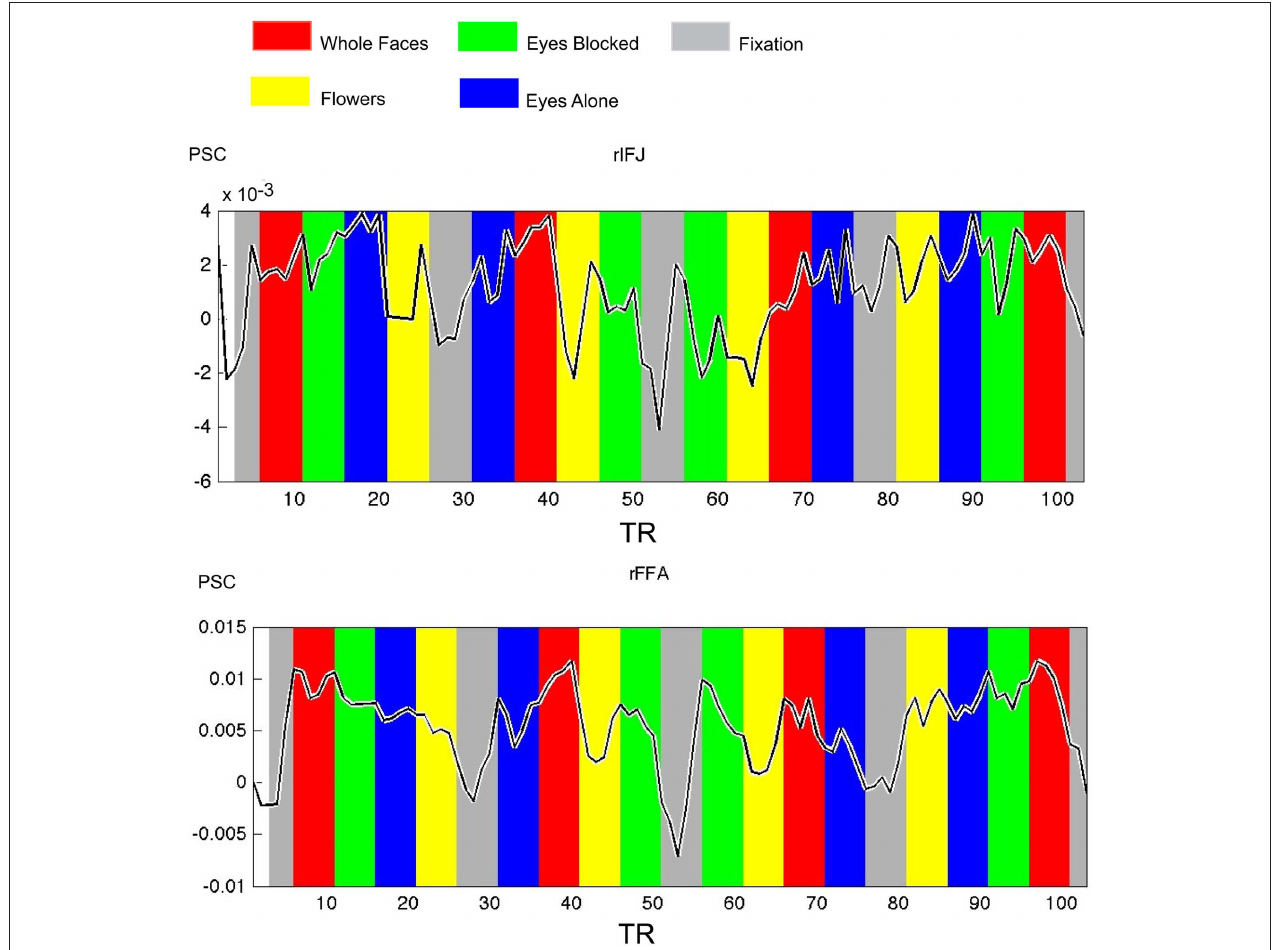
FIguRe 4 | Times courses extracted from ROIs within each participant in experiment 2, both IFJ and FFA were identified by the localizer scans (faces vs tool, p < 0.0001; N = 6). Mean percent signal change (PSC) is plotted along the y -axis, repetition time (TR) is plotted on the x -axis. The colored bars in the figure are shifted by two timepoints to accommodate the HRF.